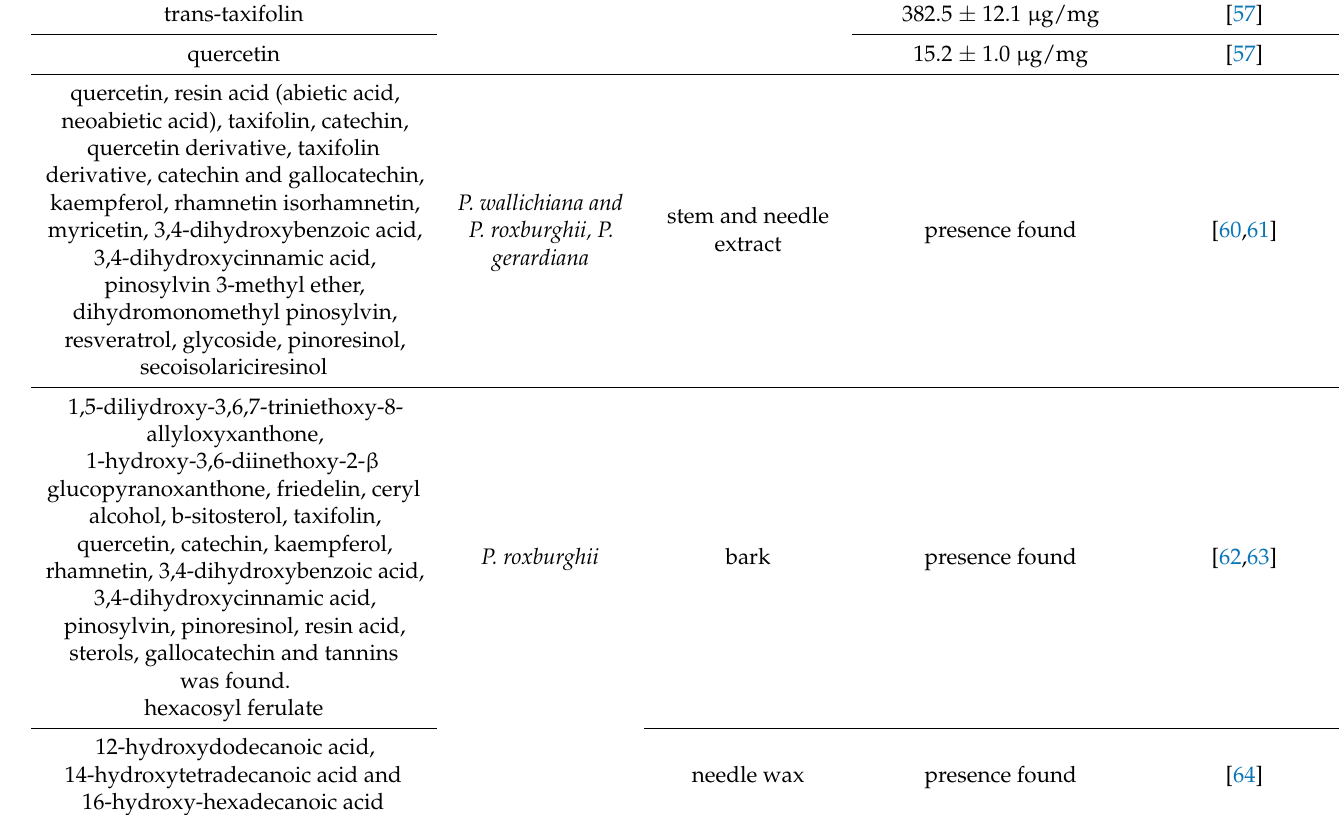
needle wax presence found Abbreviation dw—dry